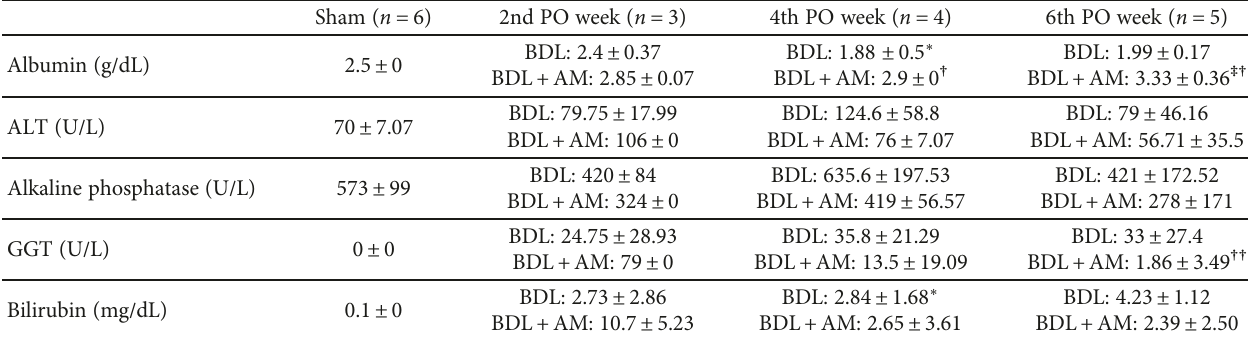
Table 4: Liver function tests.